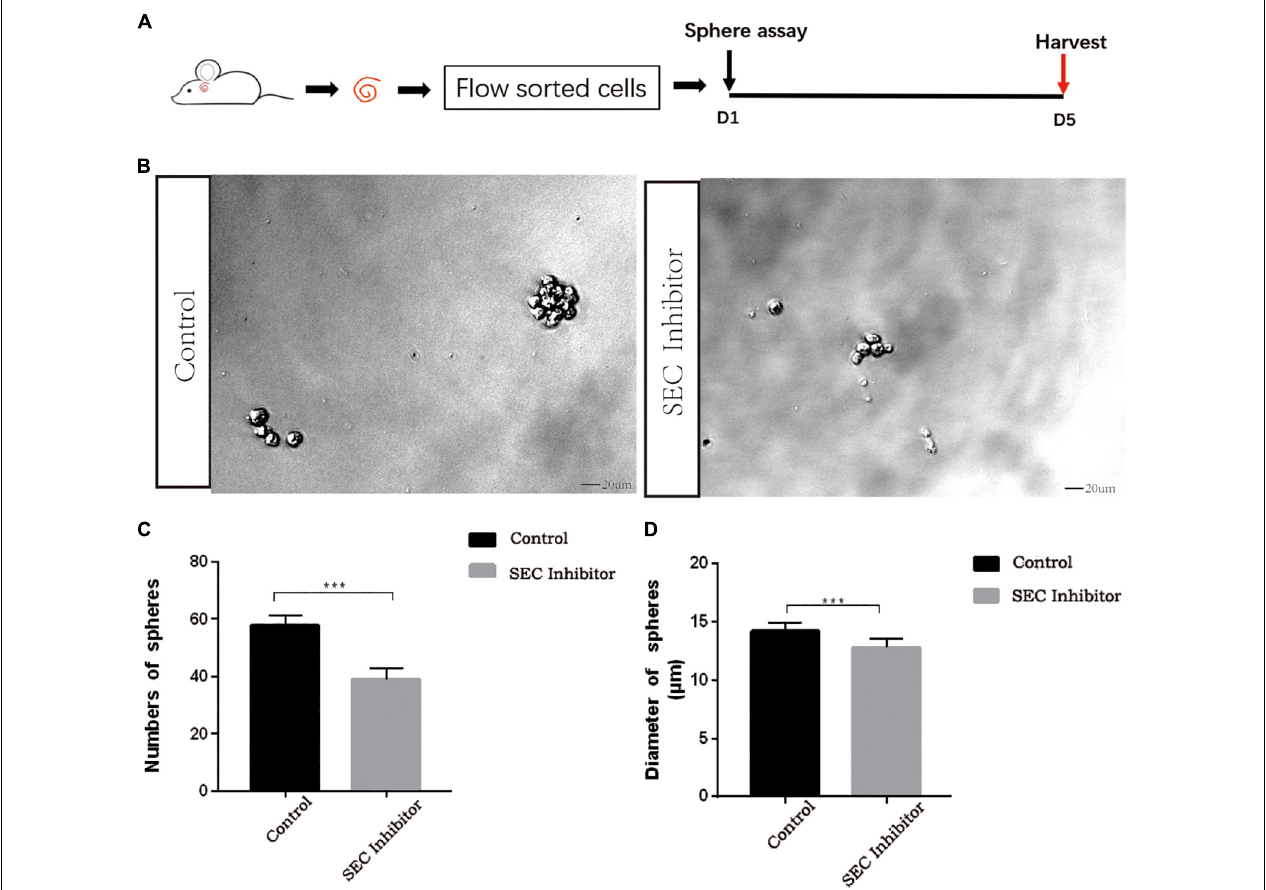
FIGURE 4 | The sphere-forming assay of Lgr5+ progenitors after inhibition of the super elongation complex (SEC). (A) Schematic of the sphere-forming assay. The cochleae of neonatal Lgr5-EGFP-CreER mice were trypsinized for FAC sorting, and the sorted Lgr5+ progenitors were cultured in vitro for 5 days to form spheres with or without 10 µ M flavopiridol treatment. (B) The spheres (indicated by black arrows) formed by Lgr5+ progenitors with 10 µ M flavopiridol added as the SEC inhibitor. DMSO was added as control treatment in the Control group. Scale bar = 20 µ M. (C,D) Quantification of the sphere number per well (C) and the sphere diameter (D) . n = 3. *** P <